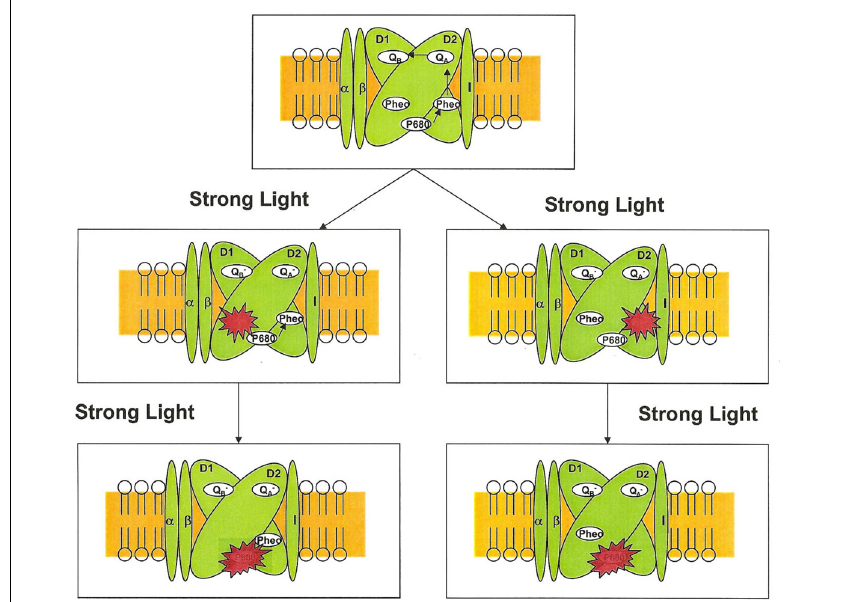
FIGURE 1 | Unidirectional photodamage of pheophytin in PS II reaction